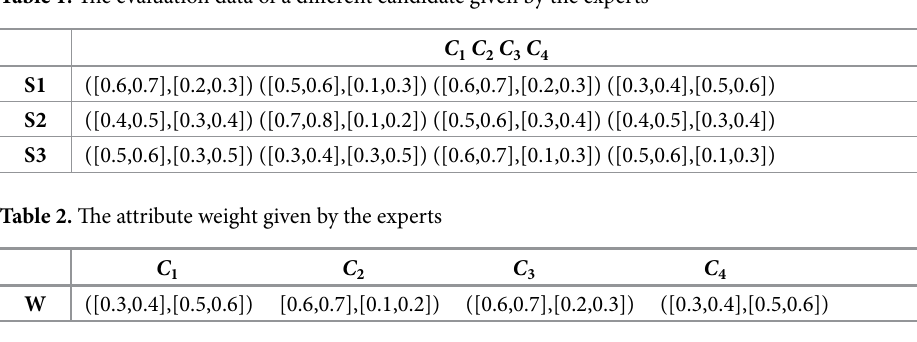
Table 1. The evaluation data of a different candidate given by the experts